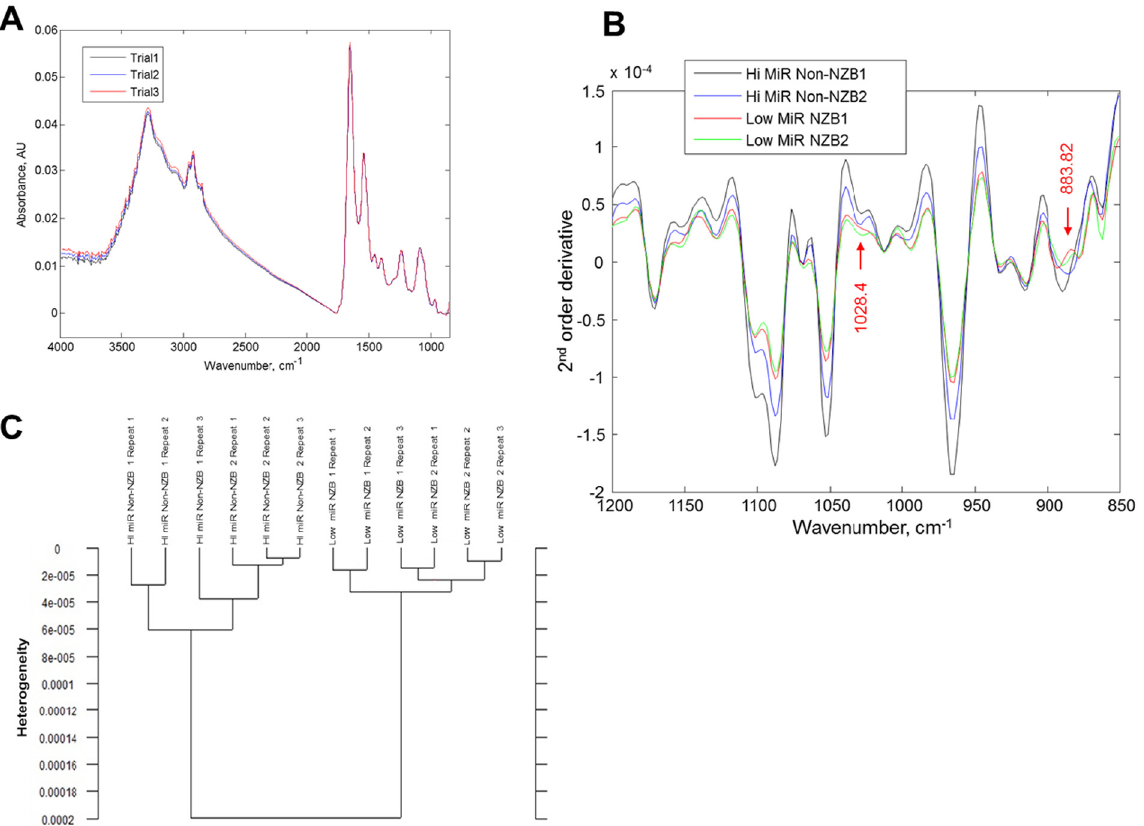
Fig 3. Spectroscopic Analysis (FTIR) identifies miR-15a/16-1 differences. A ) FTIR absorption spectra of spleen cells (NZB, repeated three times). Cells were air-dried on an area of 4mm 2 on CaF 2 coated surface. B ) 2 nd order derivative spectra of spleen cells in 1200-850cm -1 range. Spectral variations were observed between the non-NZB (DBA strain no CLL) with high miR-15a/16-1 levels when compared to the NZB spleen source. These were observed at 883.82 and 1028.4 cm -1 indicated by arrows. C ) Hierarchical clustering was performed to investigate the effect of microRNA miR-15a/16-1 levels in spleen cells from DBA (high miR-15a/16-1) versus NZB (low miR-15a/16-1) using Ward ’ s algorithm and 2 nd order derivative spectra at 883.82 cm -1 and 1028cm -1 .